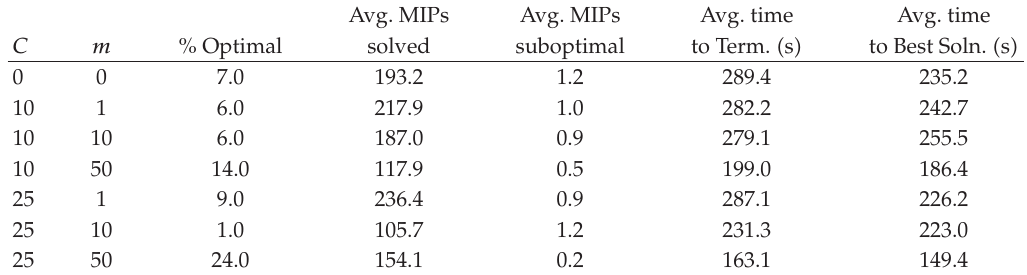
Table 5: Computational performance of L 1 OR implementation for simulation with vertical outliers.